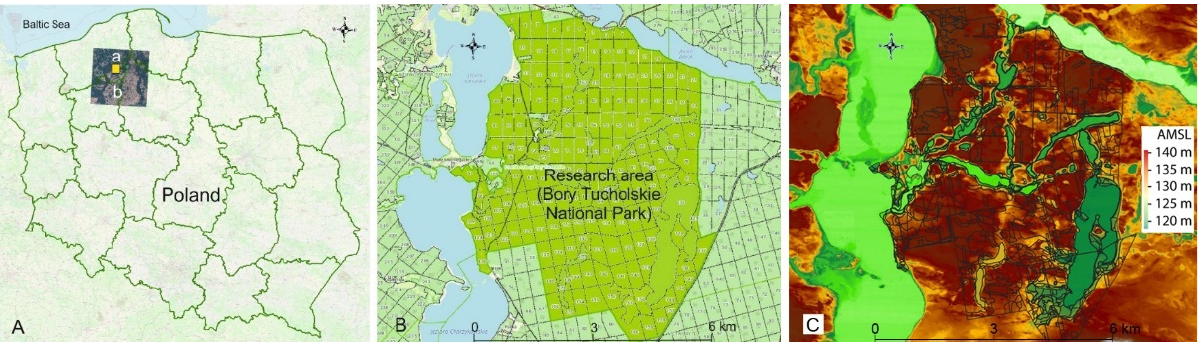
Figure 1. Location of the research area in northern Poland (yellow square, ( A )-a); ( A )-b: satellite image on the background of the map of Poland used in the research; ( B )—the area of BTNP, ( C )—elevation map of research area.